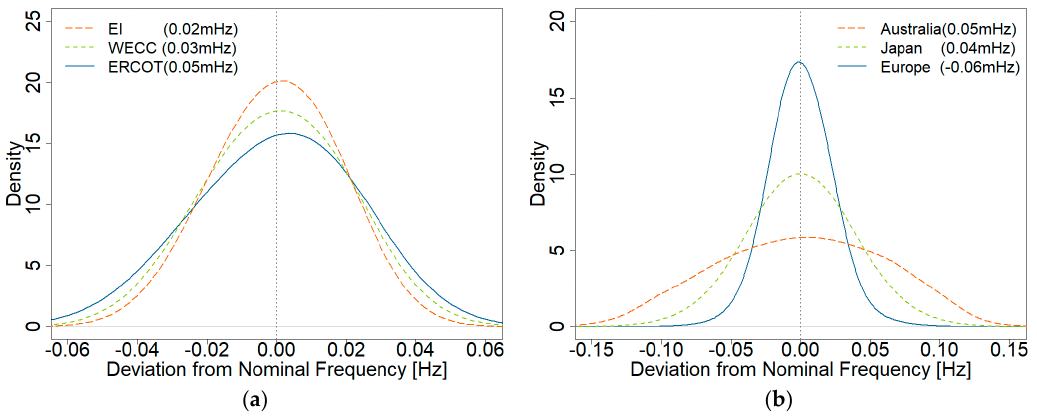
Figure 13. Probability distribution of power system frequency in countries providing the time error correction in 2016. ( a ) Three major interconnection systems in North America; ( b ) Interconnection systems around the world. Figures in brackets denote the average frequency deviation away from the nominal frequency.